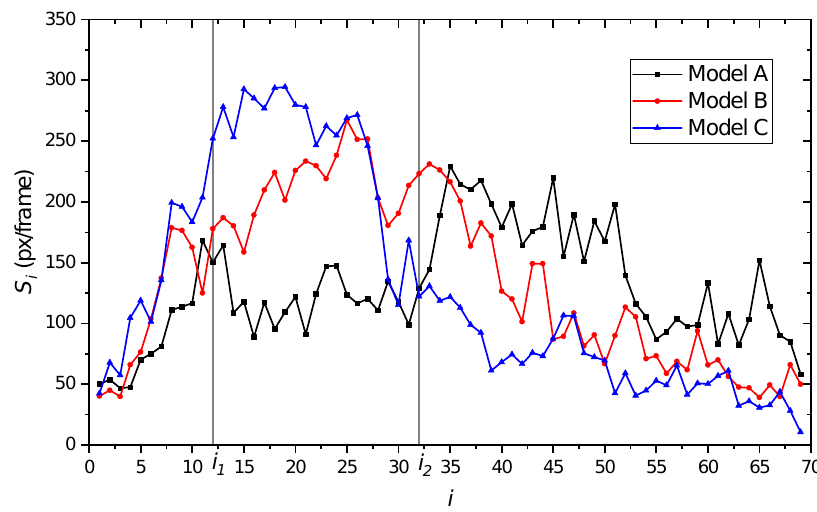
Figure 16. Vertical velocity statistic distribution of the three valve core